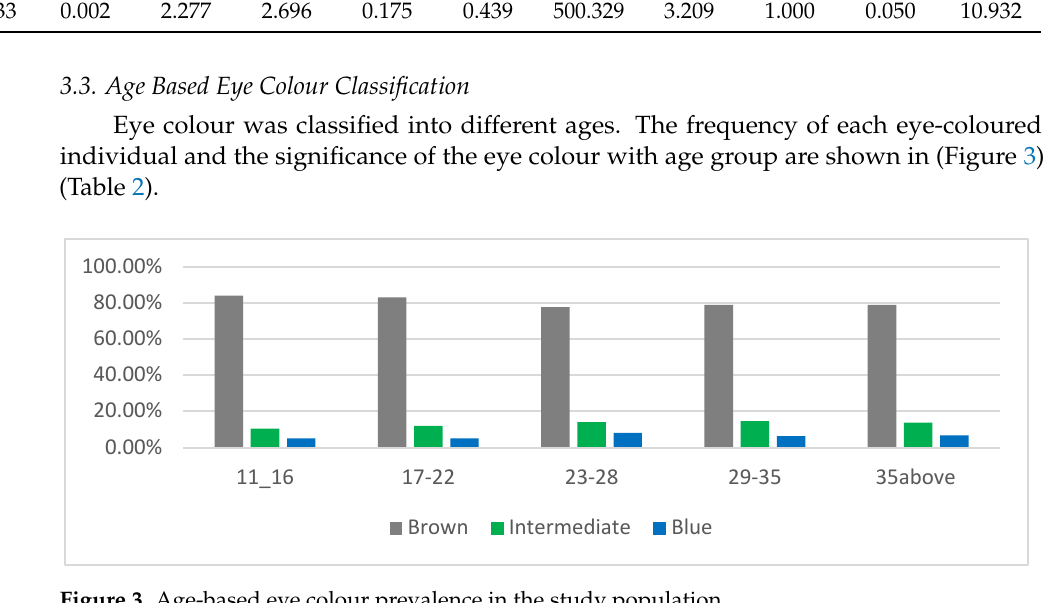
Figure 3. Age-based eye colour prevalence in the study population. Table 2. Multinomial logistic regression analysis between age groups and eye colour .